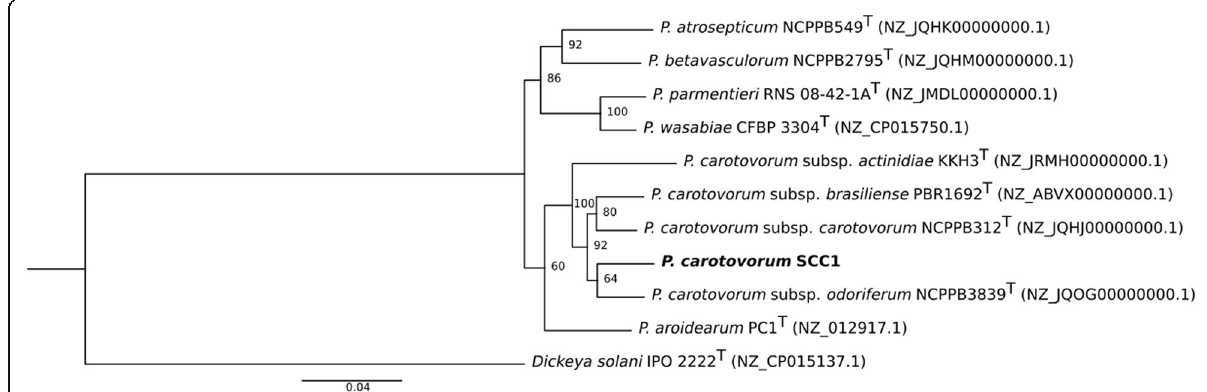
Fig. 2 Maximum likelihood tree of Pectobacterium carotovorum SCC1 and other closely related Pectobacterium strains. The phylogenetic tree was constructed from the seven housekeeping genes ( dnaN, fusA, gyrB, recA, rplB, rpoS and gyrA ). The concatenated sequences were aligned using MAFFT multiple sequence alignment program (version 7) with default parameters [42]. The phylogenetic tree was built in RAxML (Randomized Axelerated Maximum Likelihood) program with Maximum likelihood (ML) inference [43]. 88 different nucleotide substitution models were tested with jModelTest 2.0 and the best model was selected using Akaike information criterion (AIC) [44]. Bootstrap values from 1000 replicates are shown in each branch. Dickeya solani IPO2222 was used as the outgroup. Type strains are marked with T after the strain name. GenBank accession numbers are presented in the parentheses. The scale bar indicates 0.04 substitutions per nucleotide